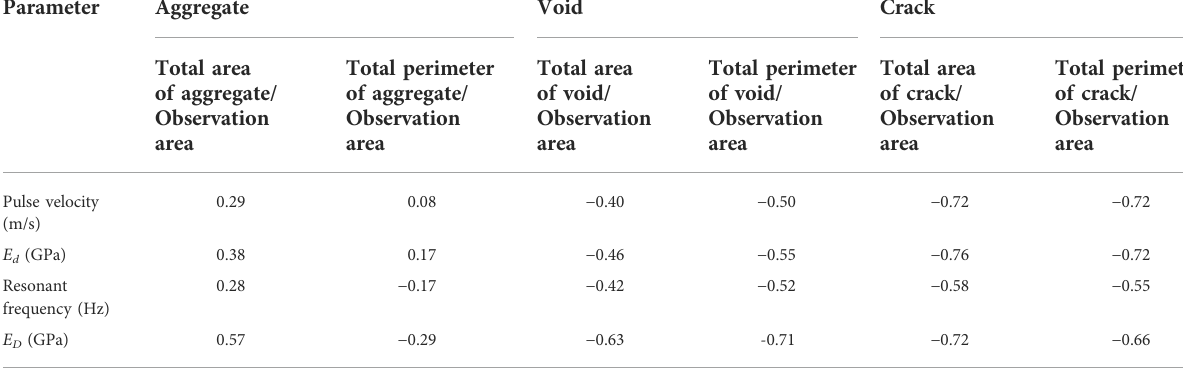
TABLE 6 Correlation between NDT parameters and proportions parameters of concrete components.